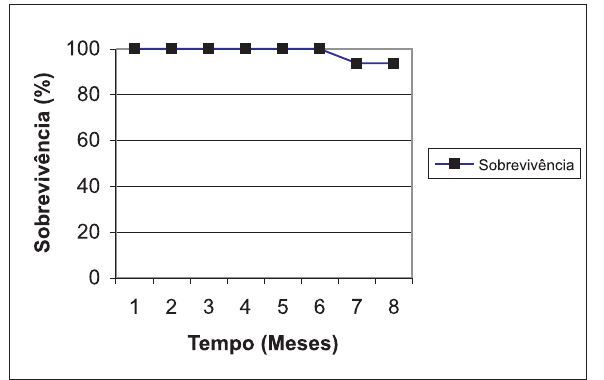
Fig. 6 - Estudo angiográfico pré-operatótio evidenciando obstruções graves de artéria DA, 1 a diagonal e 2 a marginal da circunflexa.